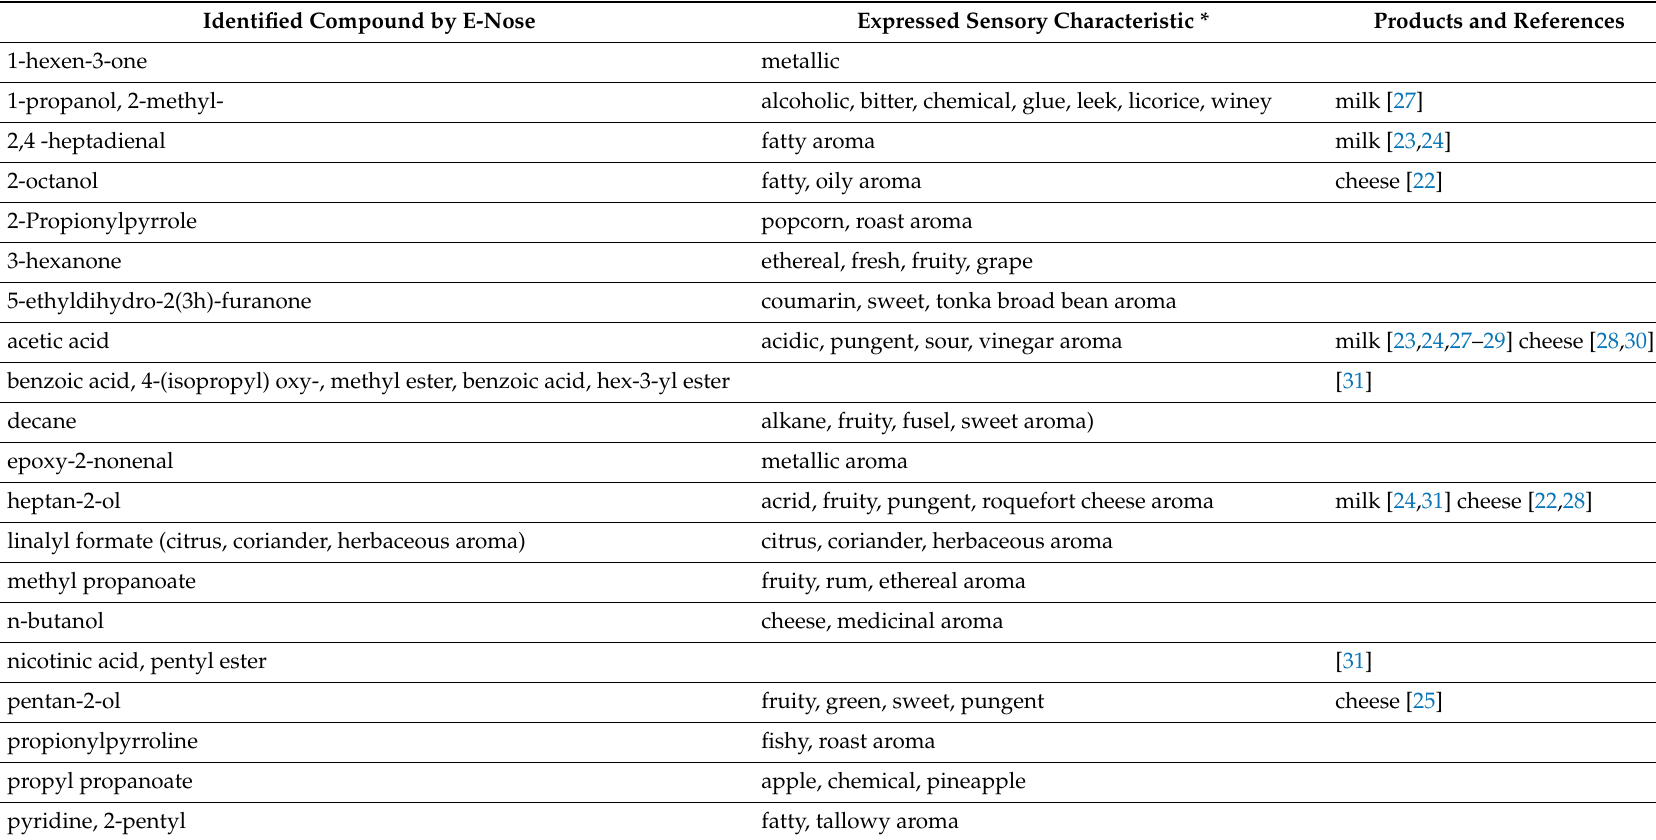
Table 1. Compounds identified by the electronic nose during milk fermentation and their expressed sensory characteristics and comparison with